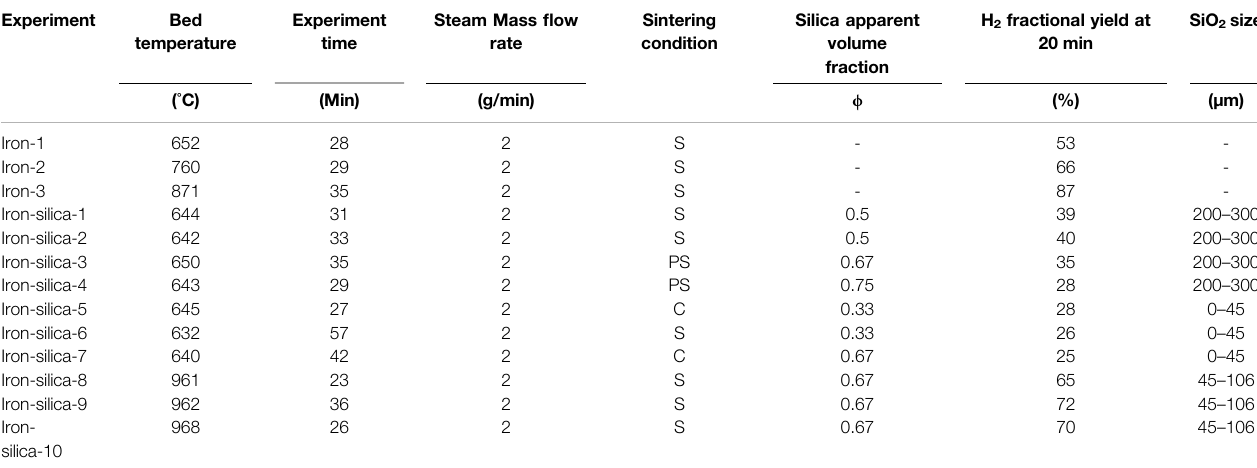
TABLE 1 | Experiments for iron and crystalline silica mixture.